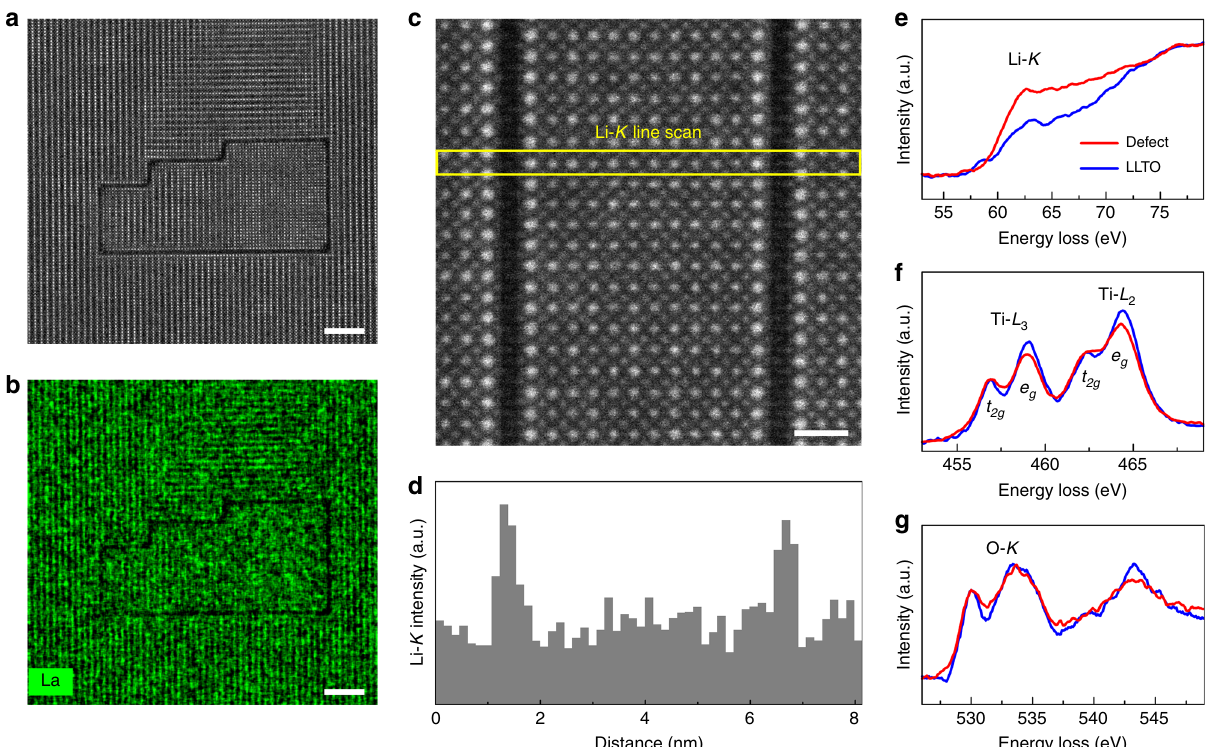
Fig. 2 EDX and EELS analyses of the 2D defects. a , b HAADF-STEM image ( a ) and the corresponding EDX mapping result ( b ) of a SALT formed by the 2D defects. The scale bars in a and b are both 5 nm. c , d HAADF-STEM image ( c ) and the Li- K intensity pro fi le ( d ) obtained via EELS line scan in the region indicated by the yellow rectangle in c . The scale bar in c is 1 nm. e – g EELS results of Li- K ( e ), Ti- L 2,3 ( f ), and O- K ( g ) for the 2D defect and bulk